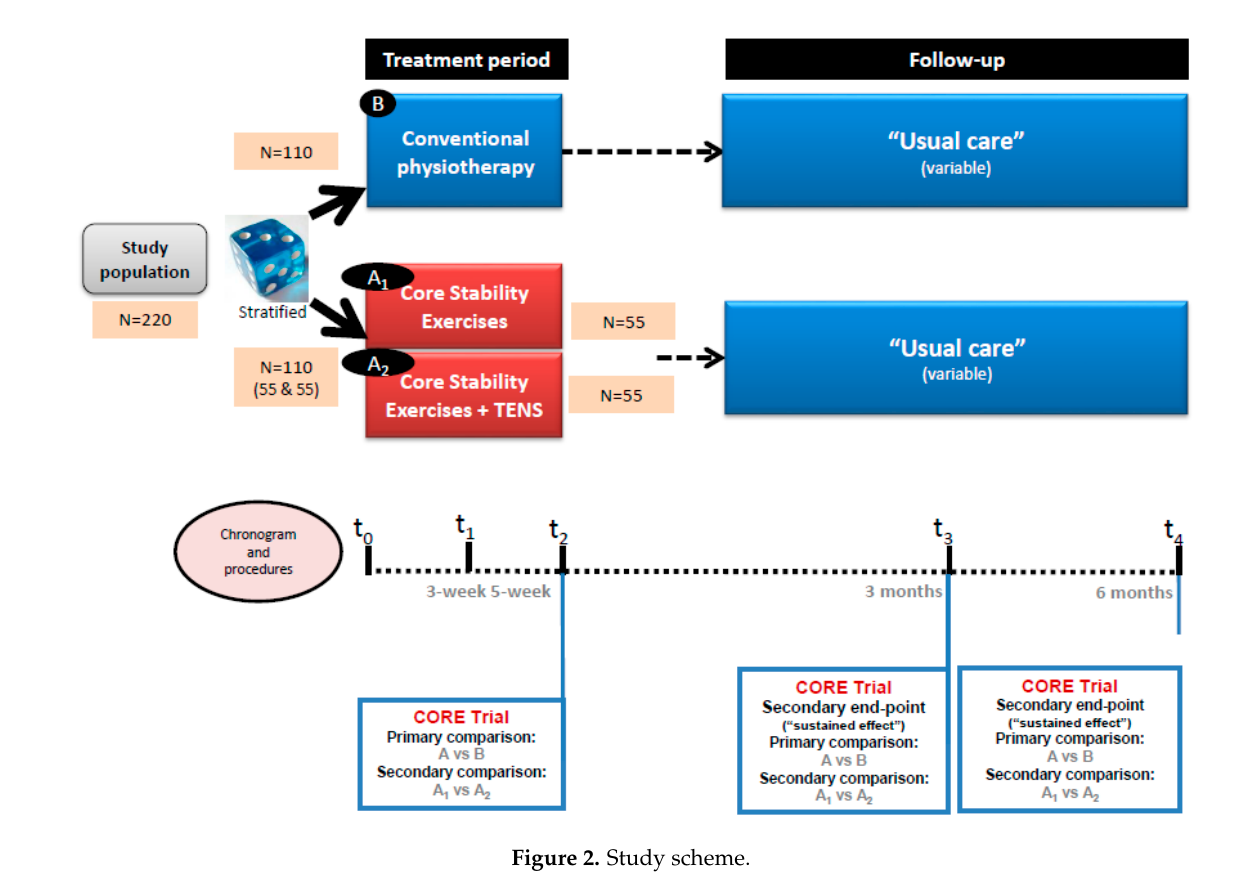
Figure 2. Study scheme.